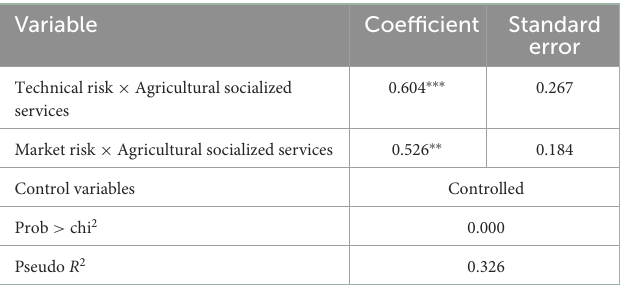
TABLE 5 Test results of the moderating effect of agricultural socialized